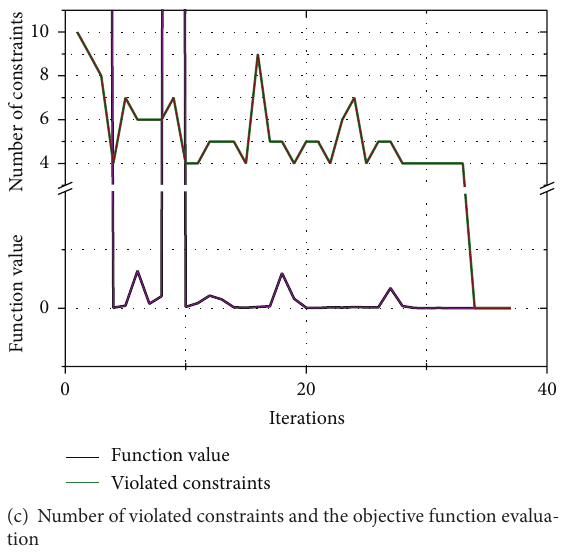
Figure 9: Analysis: the server room case study.